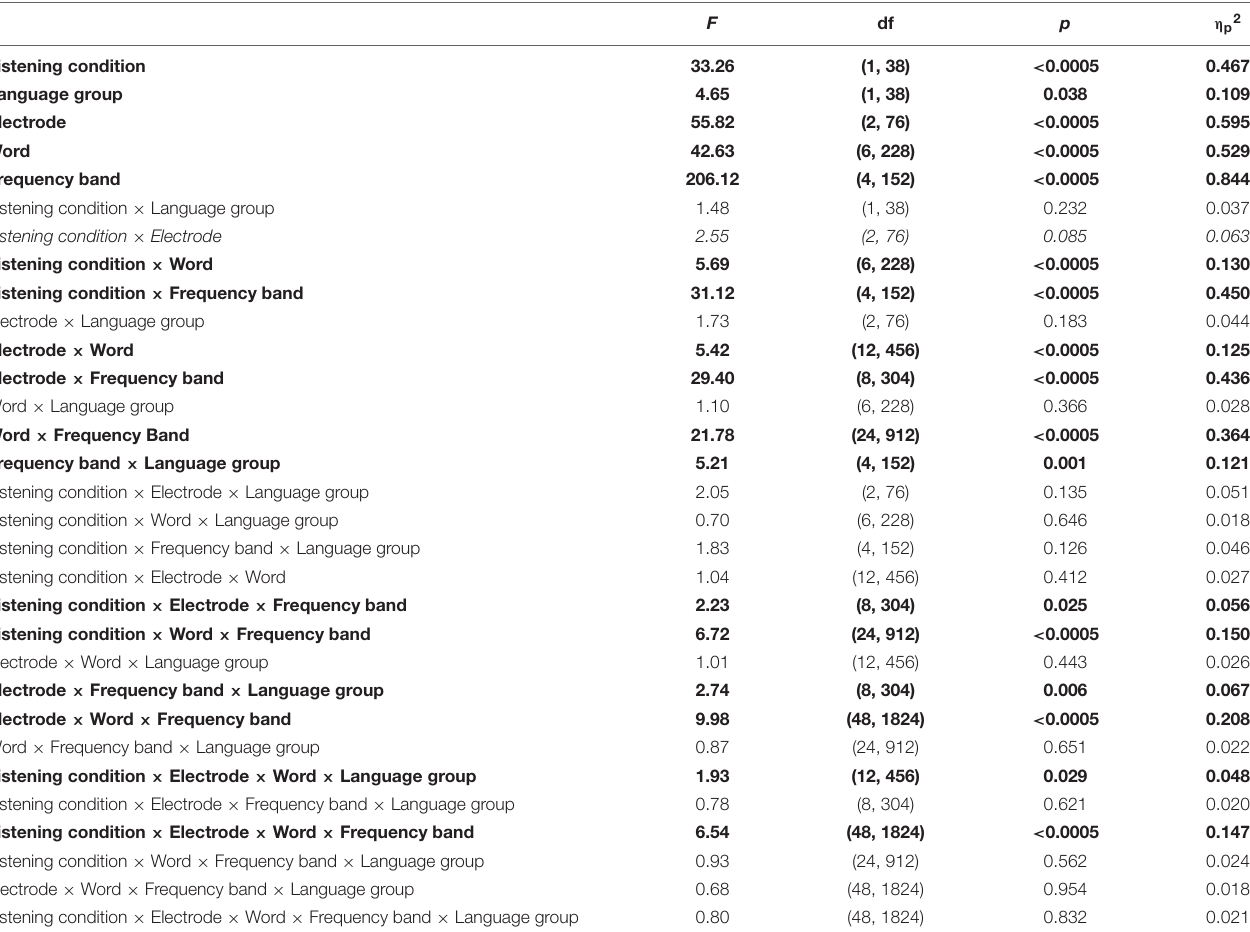
TABLE 2 | Cortical main effects and interactions for 2 (language group: monolingual, bilingual) × 2 (listening condition: active, passive) × 3 (electrode: Fz, Cz, Pz) × 7 (word: ‘ready,’ [call-sign], ‘go,’ ‘to,’ [color], [number], ‘now’) × 5[frequency band: theta (3–7 Hz), alpha (8–12 Hz), beta (20–30 Hz), gamma (31–50 Hz), and high gamma (65–150 Hz)]